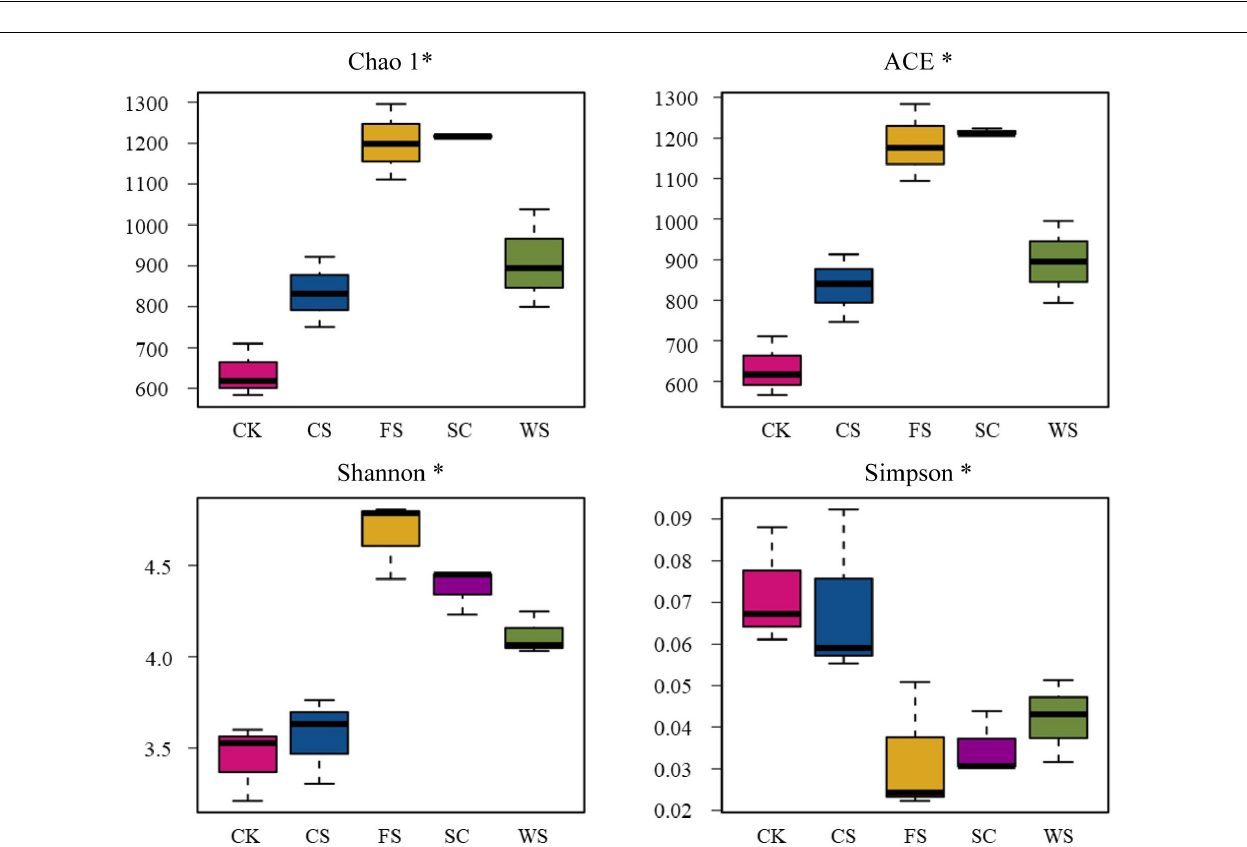
FIGURE 2 | Chao1 index, ACE index, Shannon index, and Simpson index for fungi in five soybean cropping systems with > 97% sequence identity. *Indicates a significant correlation ( P < 0.05).